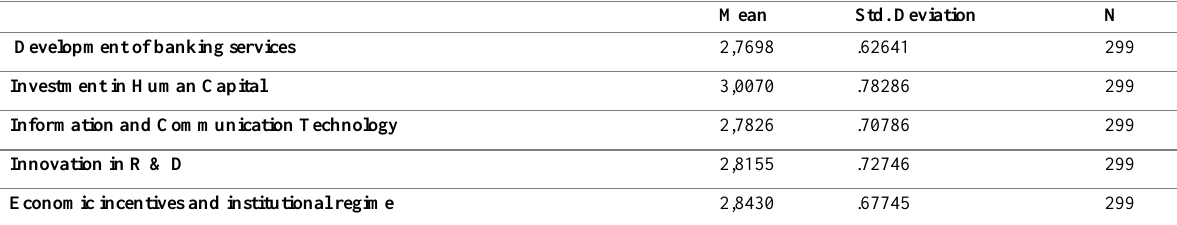
Table 4 Pearson Correlations between sub-variables of knowledge economy and sub-variables of the development of banking services. All sub-variables of knowledge economy are positively and significantly correlated with sub-variables of the development of banking services. Correlations ranged between .279 and .709, n = 299, p < .001. Table 6: Descriptive Statistics of Main Variables of the